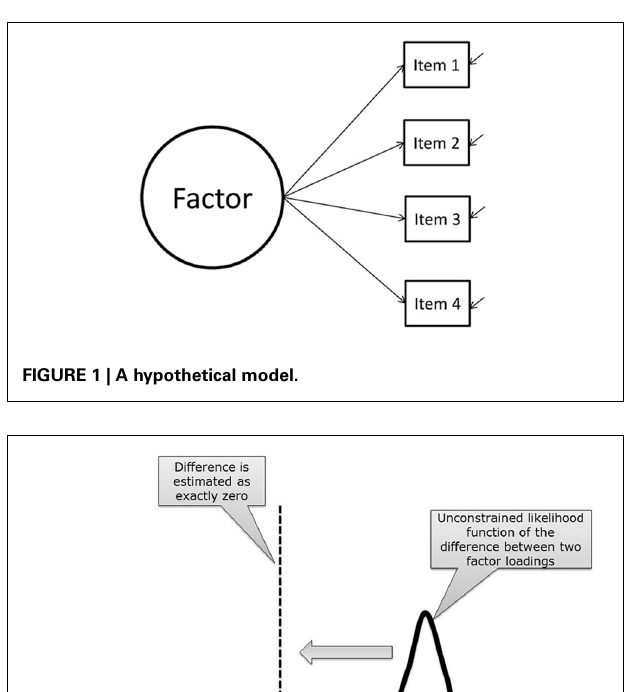
the difference between both intercepts, which is denoted by δ